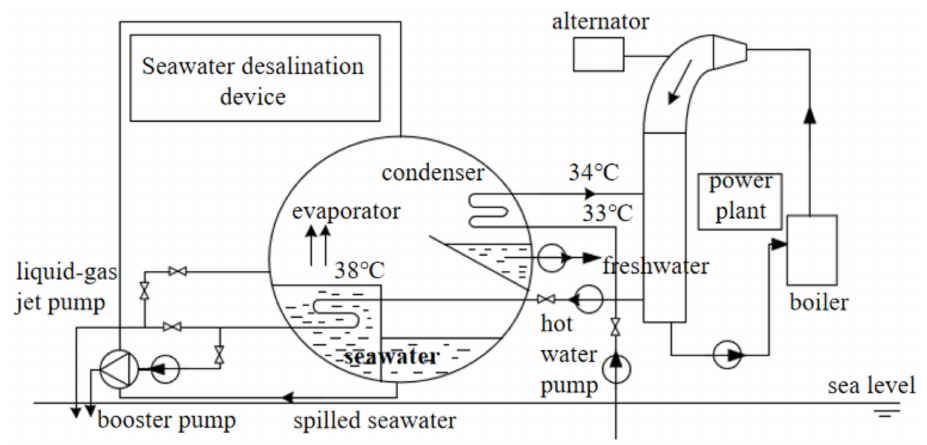
Figure 3. Seawater desalination